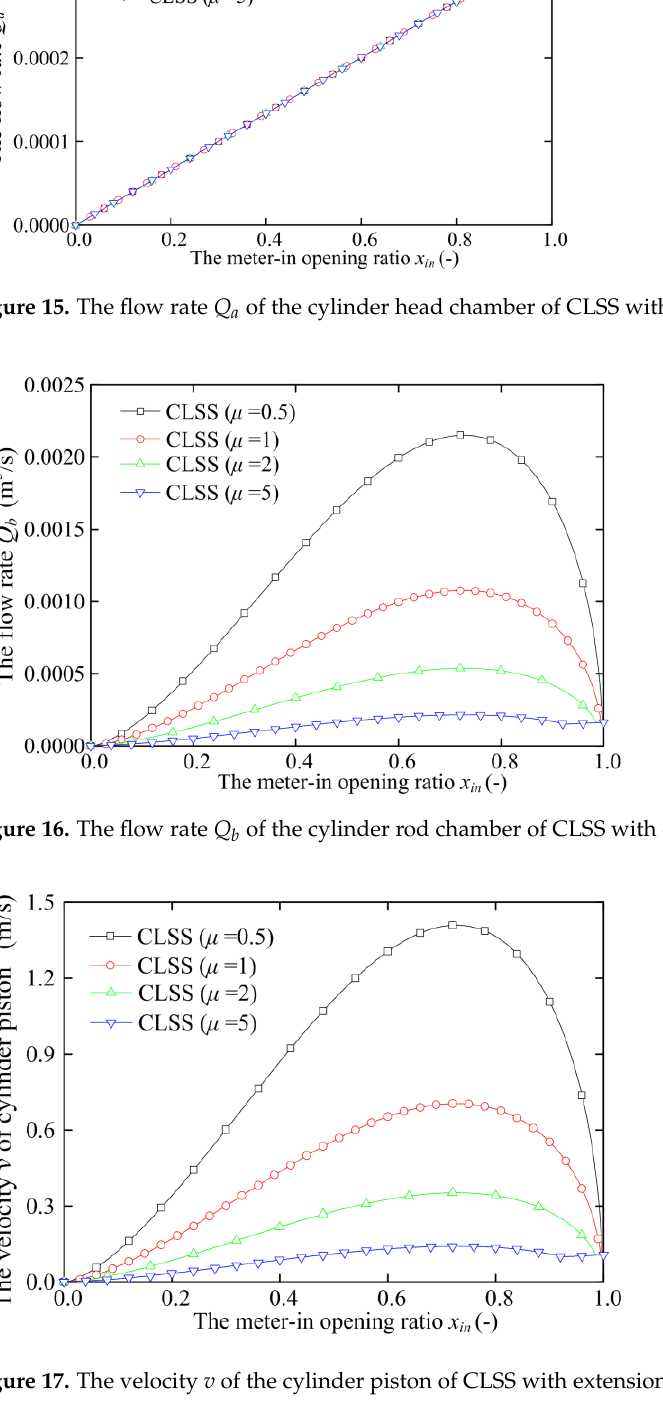
Figure 17. The velocity v of the cylinder piston of CLSS with extension working mode.